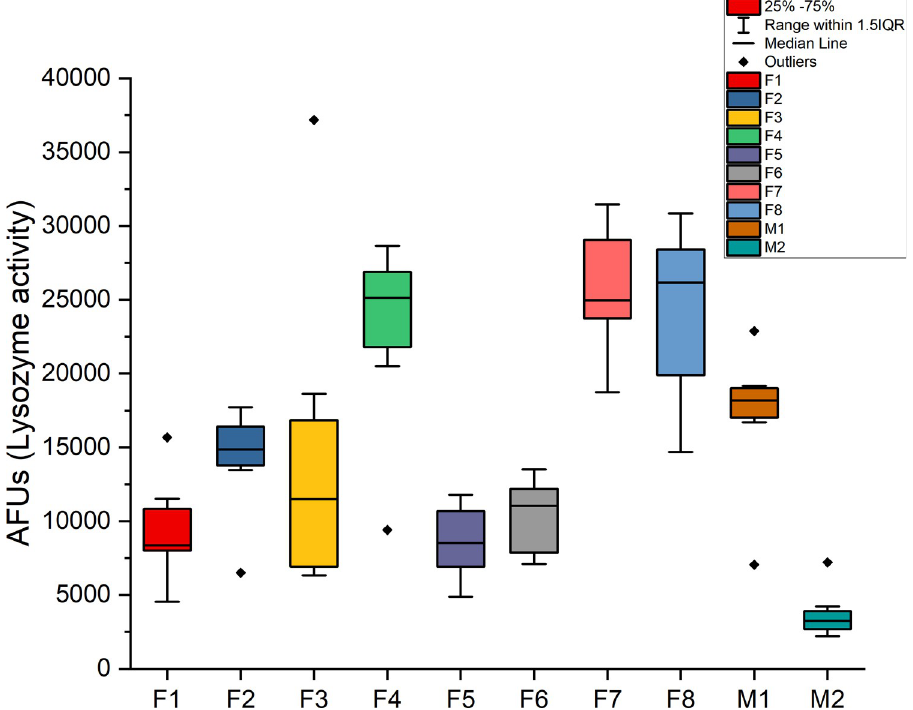
Fig 2. Lysozyme activity in untreated saliva samples. Untreated saliva samples from all individuals (n = 10) were assayed for initial rates of lysozyme activity. The average initial rate from replicates of 3 from each sample set/ individual (n = 8) were used to determine the standard deviation and median